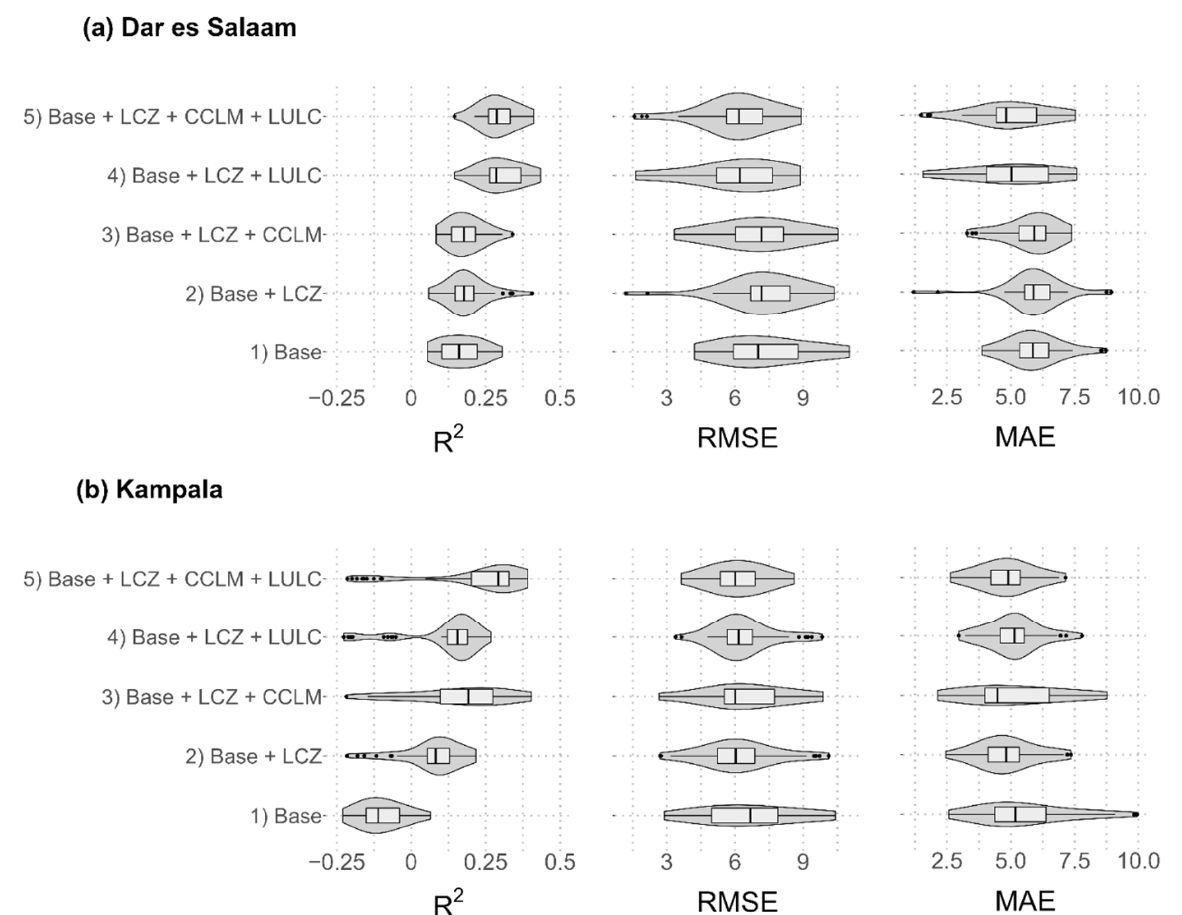
Figure 1. Comparison of model performances obtained with the five models for ( a ) Dar es Salaam and ( b ) Kampala: Base model, Base + LCZ model, Base + LCZ + CCLM model, Base + LCZ + LUCL model, and Base + LCZ + CCLM + LULC model. A recursive feature elimination (RFE) was used, except for the Base model, and this RFE was implemented independently for each model. Model performances are computed on the test sets and provided for the 50 RF models built in spatial cross-validation in terms of R-squared, root mean square error (RMSE) and mean absolute error